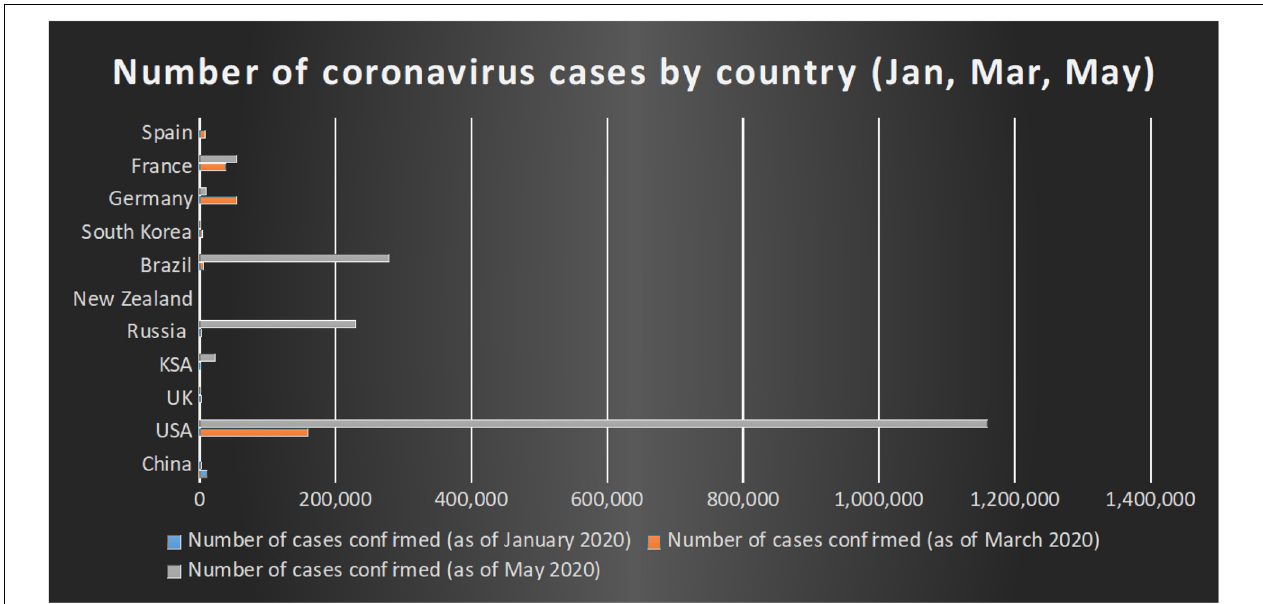
FIGURE 3 | Situation of the spread of the coronavirus in China